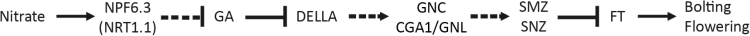
Model for regulation of flowering time by nitrate in Arabidopsis thaliana. A nitrate signal, sensed by the NPF6.3/NRT1.1 transceptor, represses a gibberellin signaling pathway that in time causes an early induction of SMZ and SNZ. Induction of SMZ and SNZ leads to early repression of the floral integrator FT, and a delay of flowering time. This model summarizes our results in a naive lineal model. However, it does not preclude multiple entries stemming from upstream signaling components (e.g. NRT1.1) over the effectors and, similarly, feedback regulation by effectors (e.g. GA pathway) towards upstream components. Dashed lines denote likely indirect regulation. The link between DELLA and the effectors GNC-CGA1/GNL is indirect and has been previously described (Richter et al., 2010).